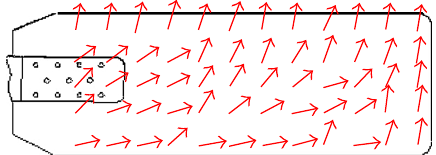
Figure 5: Computer model for flow visualization.